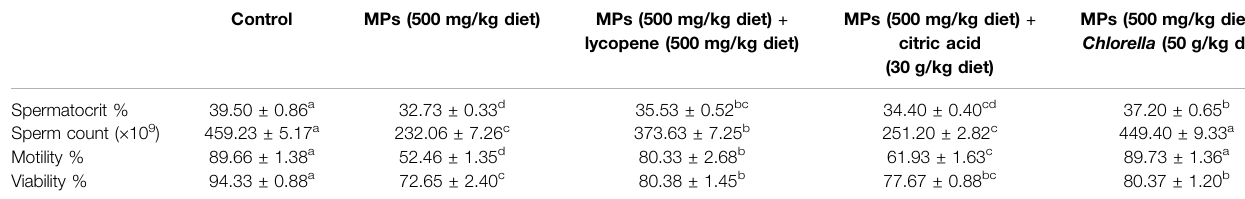
TABLE 1| Effect ofingestion ofMPs and ameliorative effect of lycopene, citric acid, and Chlorella for15 days on sperm quality ofmature male African cat fi sh ( C.gariepinus ). Data are demonstrated as mean ± SE. Different superscript letters within the same row denoted a signi fi cant difference ( p < 0.05).